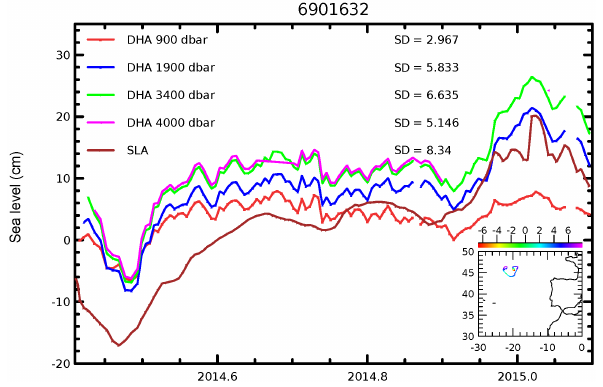
Figure 15. Temporal evolution of the standard deviation of the al- timeter SLA derived from mono-mission product (light blue), from multi-missions product (dark blue) and from Argo profiles with a 900dbar reference (magenta) and 1900dbar reference (red) in the Antarctic Circumpolar Current.